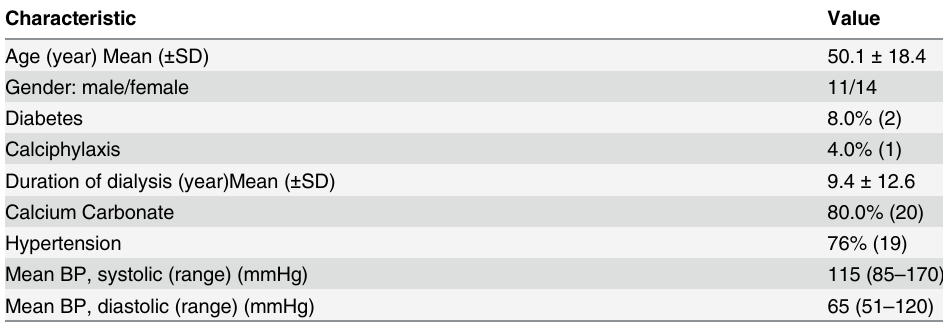
Table 1. Baseline characteristics of patients with parathyroidectomy.